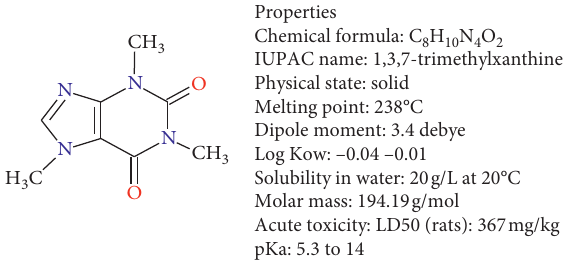
Figure 1: Chemical structure and properties of caffeine [17,